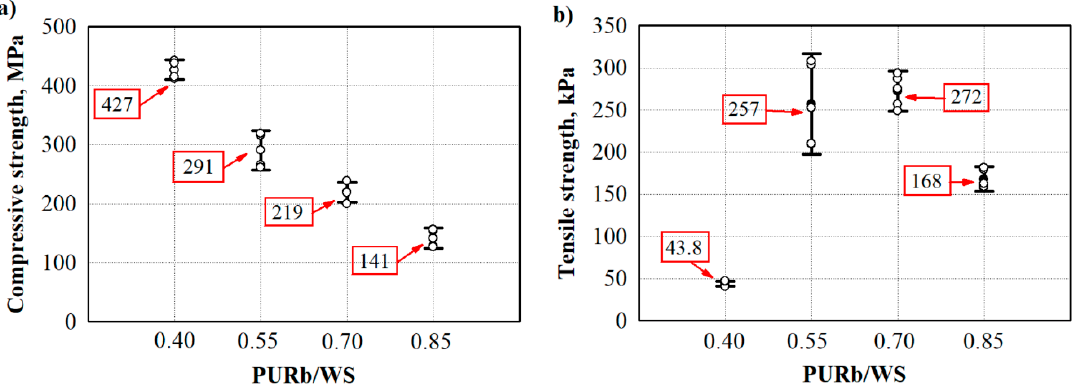
Figure 8. Strength properties of PUR biocomposite foams with different PURb/WS ratios: ( a ) compressive strength and ( b ) tensile strength. WS—cleaned sawdust, ο —single values from respective mechanical property measurements, ● —average value from respective mechanical property measurements.